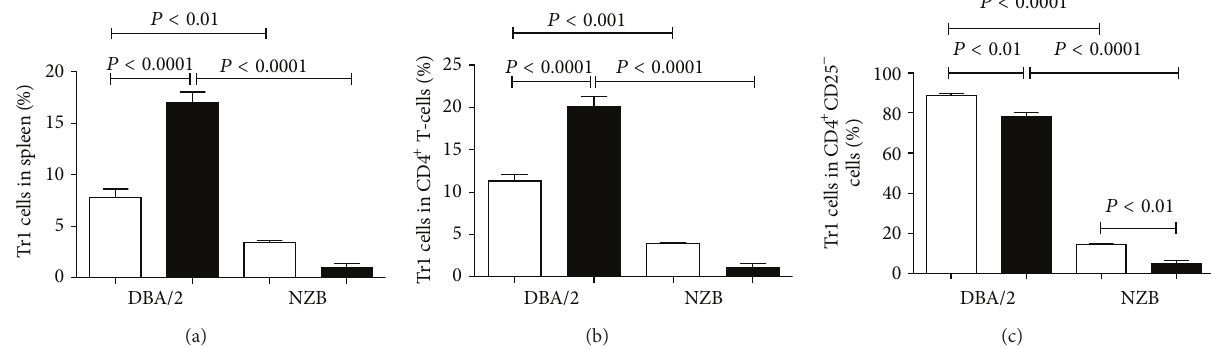
Figure 4: CD4 + CD25 − T cells in mHgIA-resistant DBA/2 possess the cytokine phenotype of regulatory T-cells. NZB and DBA/2 mice were exposed to PBS (white bar) or HgCl 2 (black bar) for 5 weeks. Splenocytes were then cultured in the presence of PMA/ionomycin and CD4 + CD25 − T-cells analyzed for the cytokine phenotype of IL-10 + IL-4 − (Tr1 cells). (a) shows the percent of Tr1 cells in total spleen. (b) shows the percent of Tr1 cells in CD4 + cells. (c) shows the percent of Tr1 cells in CD4 + CD25 − cells. 𝑛 = 4 /group.